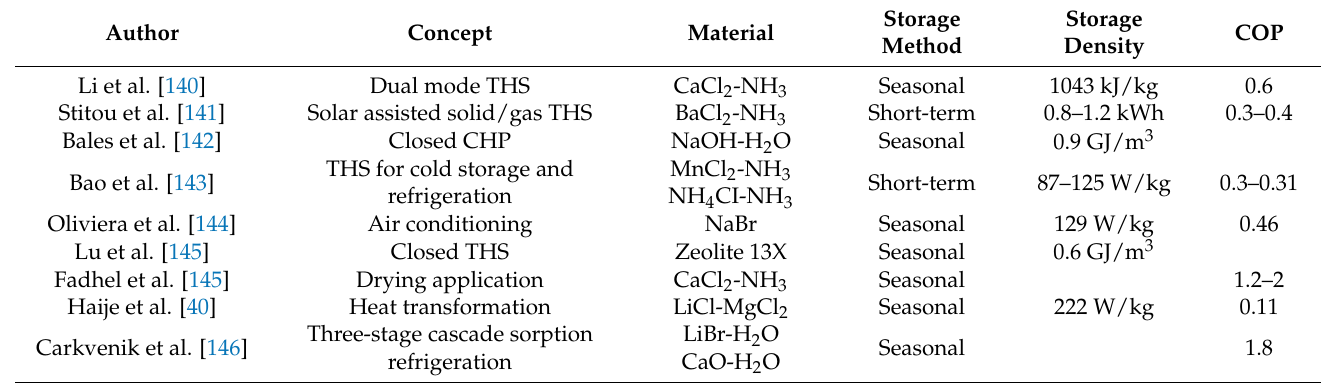
Table 9. Summary of developed prototypes of thermal storage